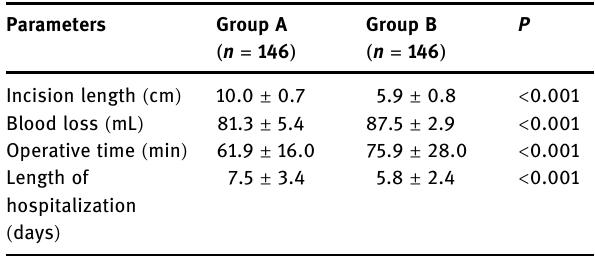
Table 3: Matched patient ’ s intraoperative characteristics between Table 3 presented matched patient ’ s intraoperative characteristics between the two groups. Compared with group A, group B had longer operative time ( 61.9 ± 16.0 vs